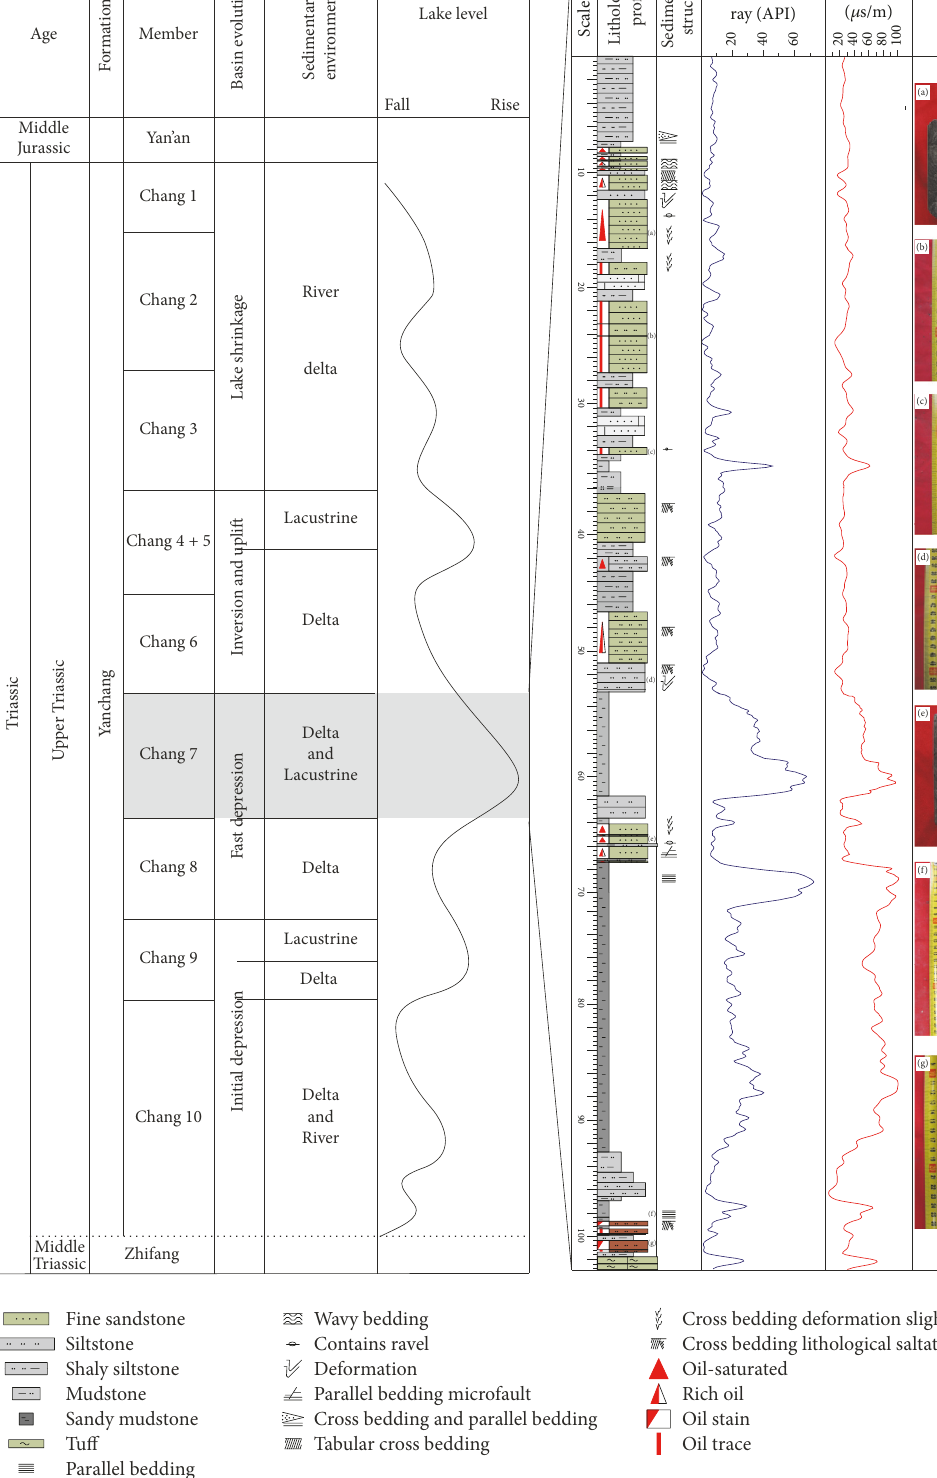
Figure 2: Stratigraphy description of the Upper Triassic Yanchang Formation with basin evolution, sedimentary environment and lake level changing curve (modified after [53]), and lithofacies, sedimentary structure, wireline log, and core photographs of the Chang 7